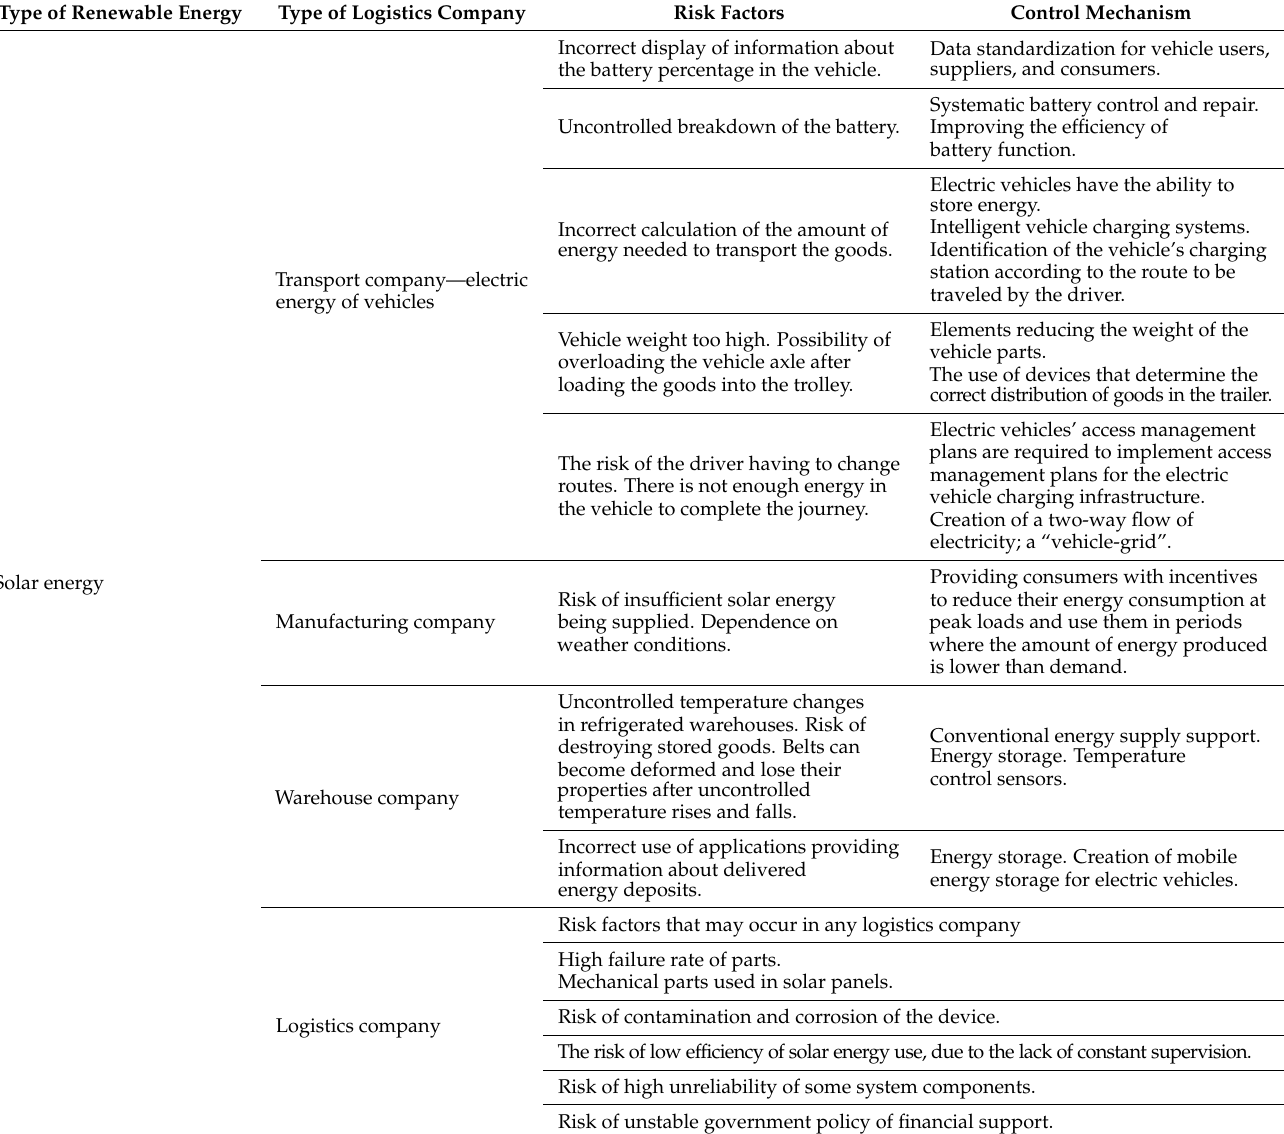
Table 2. Risk factors of a logistics company using renewable energy sources. Type of Renewable Energy Type of Logistics Company Risk Factors Control